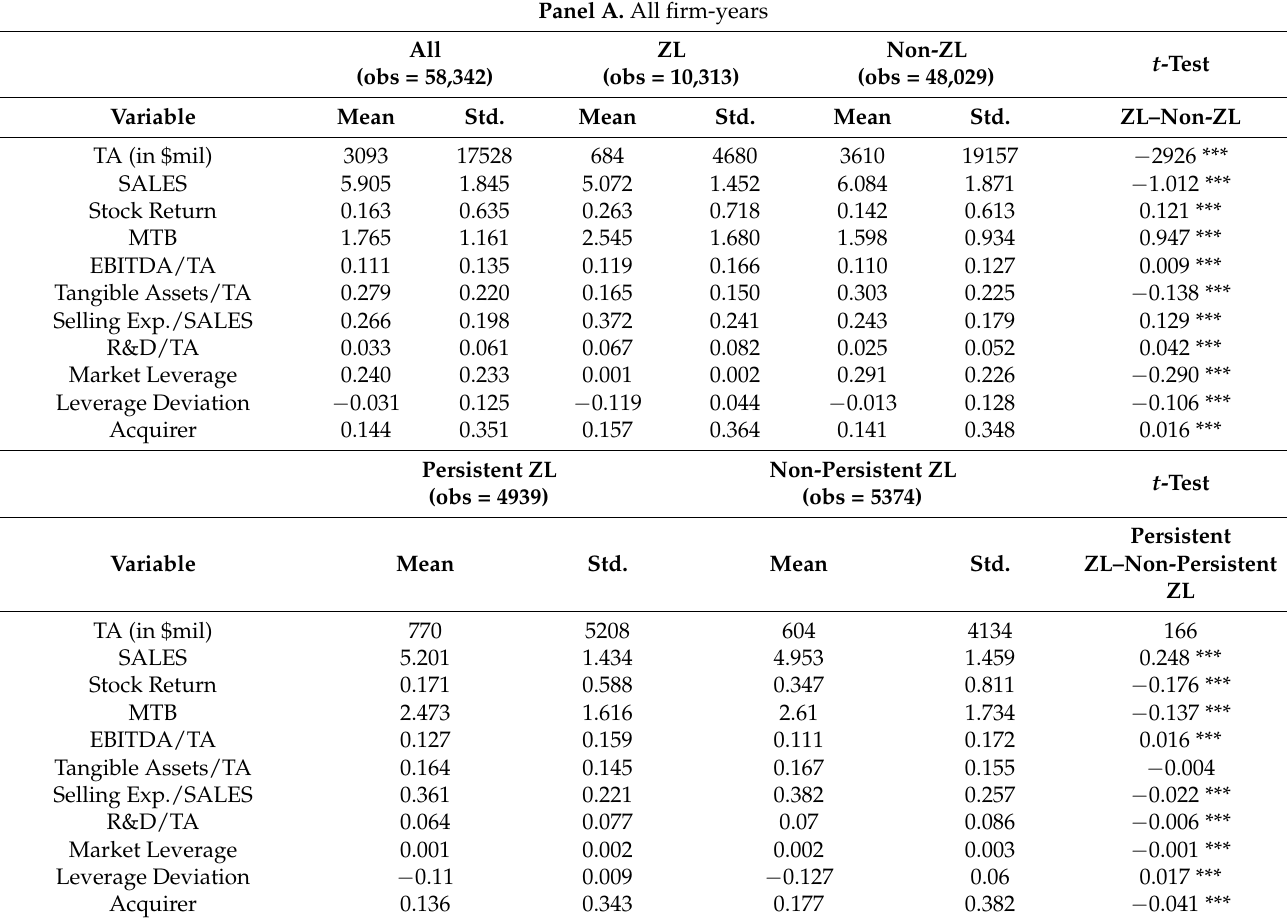
Table 3. Descriptive statistics. Panel A, reporting firm characteristics, is based on the full sample. Panel B shows the acquirer statistics for the firm-years in which the firm makes at least one acquisition. Panel C reports the statistics of the deal characteristics. Variable definitions are in the Appendix A. The t -test reports the differences in means between ZL observations and non-ZL observations. The symbols ***, **, and * denote statistical significance for two-tailed t -tests at the 1%, 5%, and 10%,